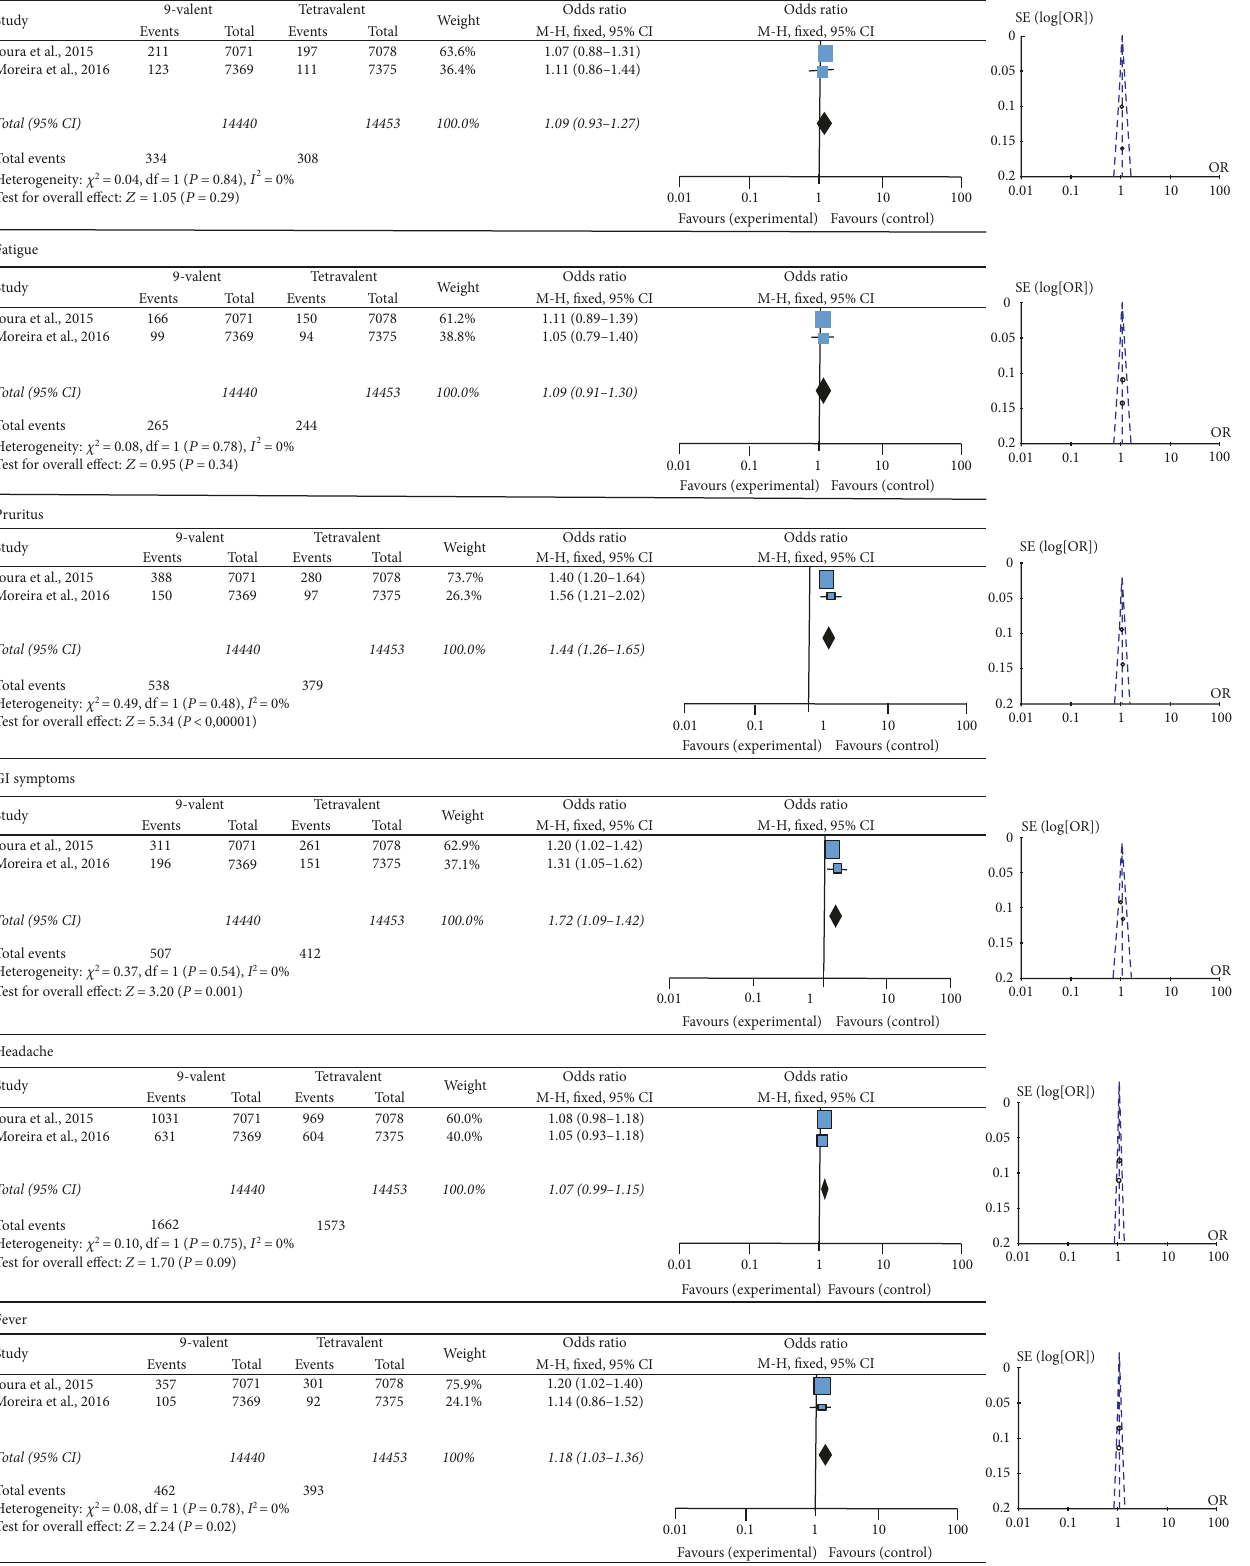
Figure 2: Forest and funnel plots of systemic adverse e ff